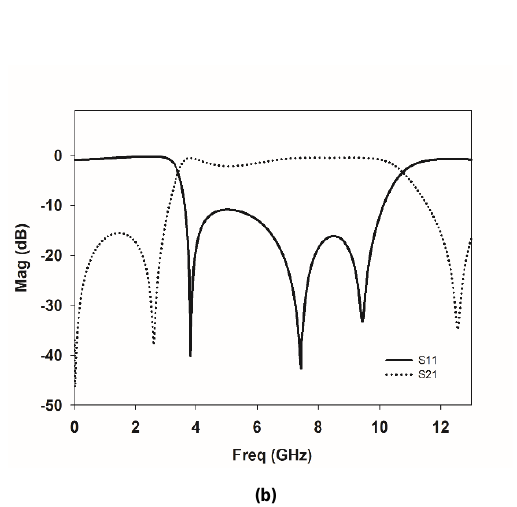
FIGURE 5. Geometry and simulation of the fourth filter design (a) Top and bottom view, (b) S-parameters.